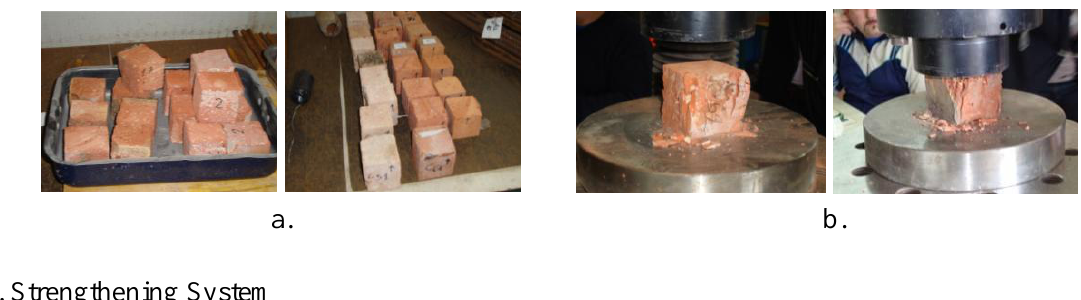
Figure 4. ( a ) Specimens extracted by cutting the bricks used for bond tests; ( b ) compressive tests.